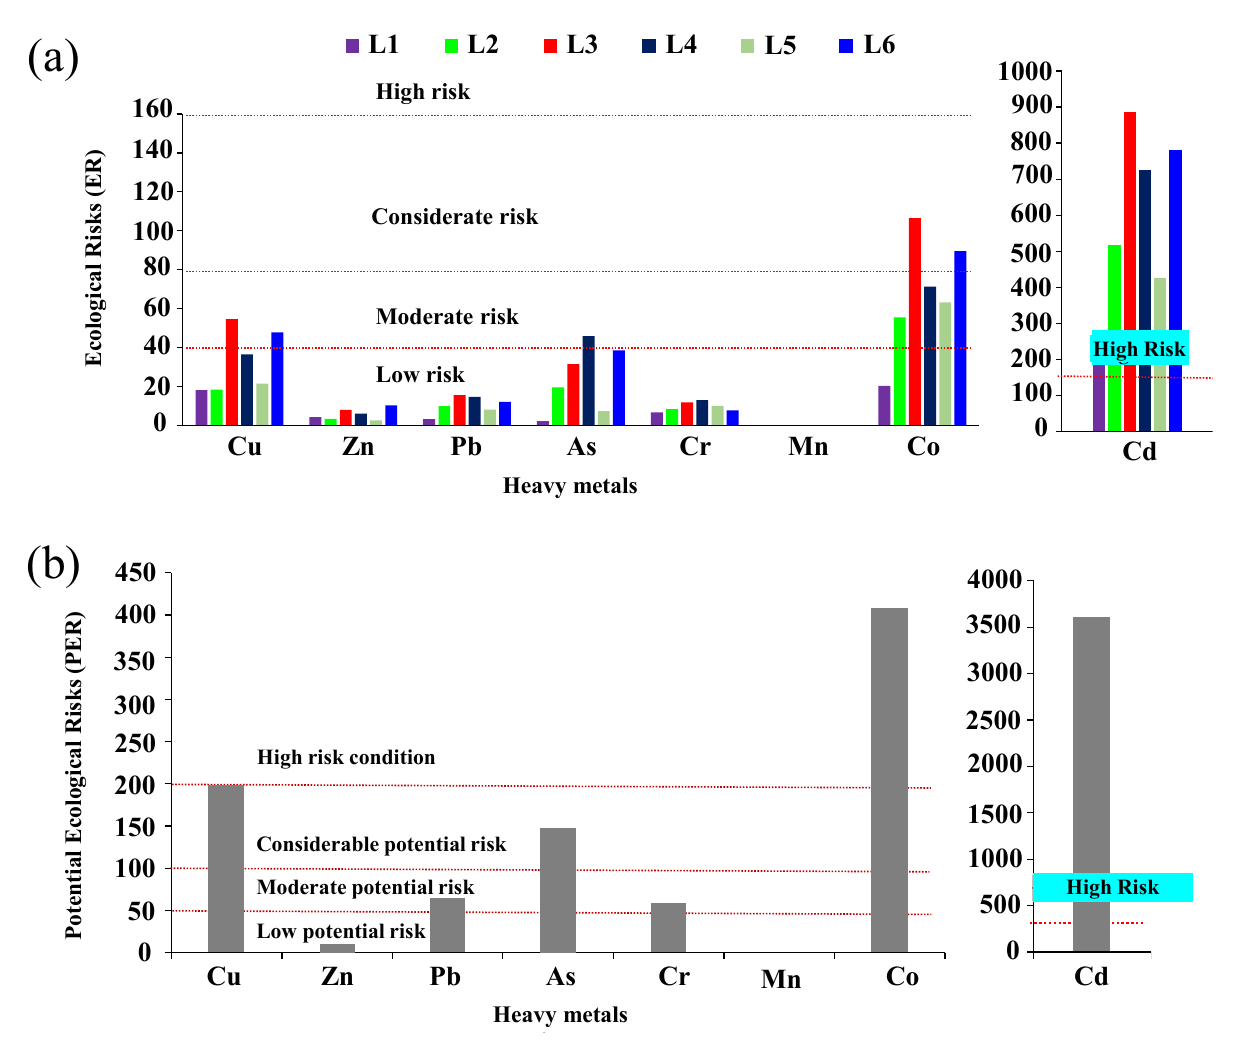
Figure 3. ( a ) Ecological risks and ( b ) potential ecological risks.